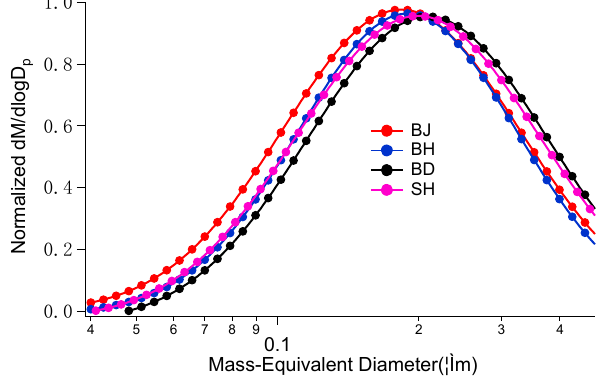
Figure 6. The average size distribution of rBC at the four locations (red for BJ, blue for BH, black for BD, and pink for SH) during the sampling.